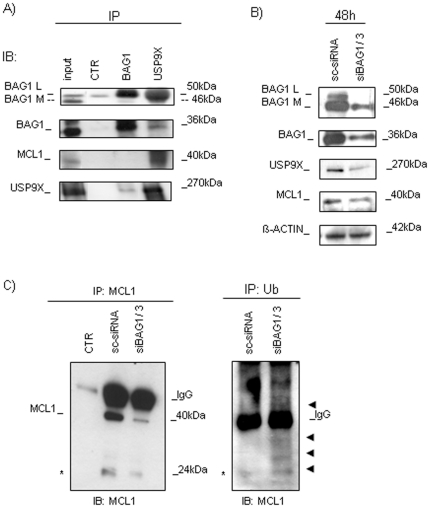
USP9X protein expression and co-immunoprecipitation analysis.A) Analysis of co-interaction between BAG1/USP9X and USP9X/MCL1 proteins was shown. IP assay was done with BAG1 and USP9X primary antibodies and IB with anti-BAG1, anti-USP9X or anti-MCL1 primary antibodies. B) Effects of BCS on USP9X and MCL1 protein expression were analyzed by WB. β-ACTIN is shown as total protein loading control. C) MCL1 was immunoprecipitated after silencing, and the IB analyses with anti-MCL1 and anti-Ubiquitin (Ub) proteins were done. The arrows indicate an increased smear of ubiquitinated proteins after BCS. Asterisk indicates the cleaved form of Mcl-1 [52].